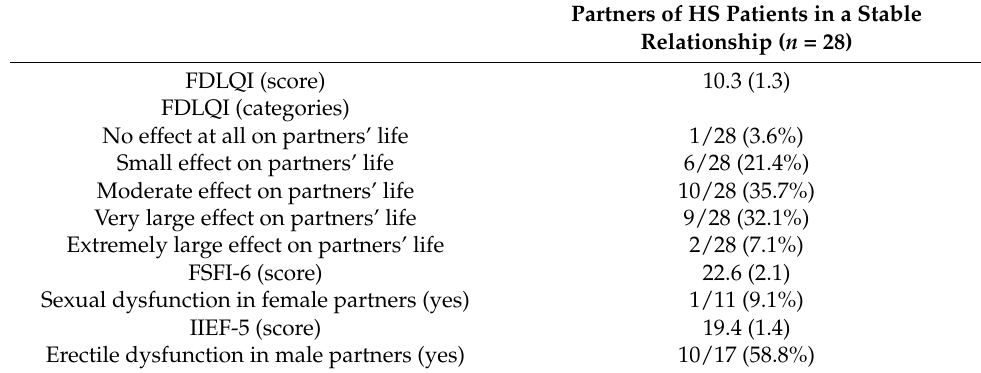
Table 3. Quality of life and sexual function in patients’ partners.